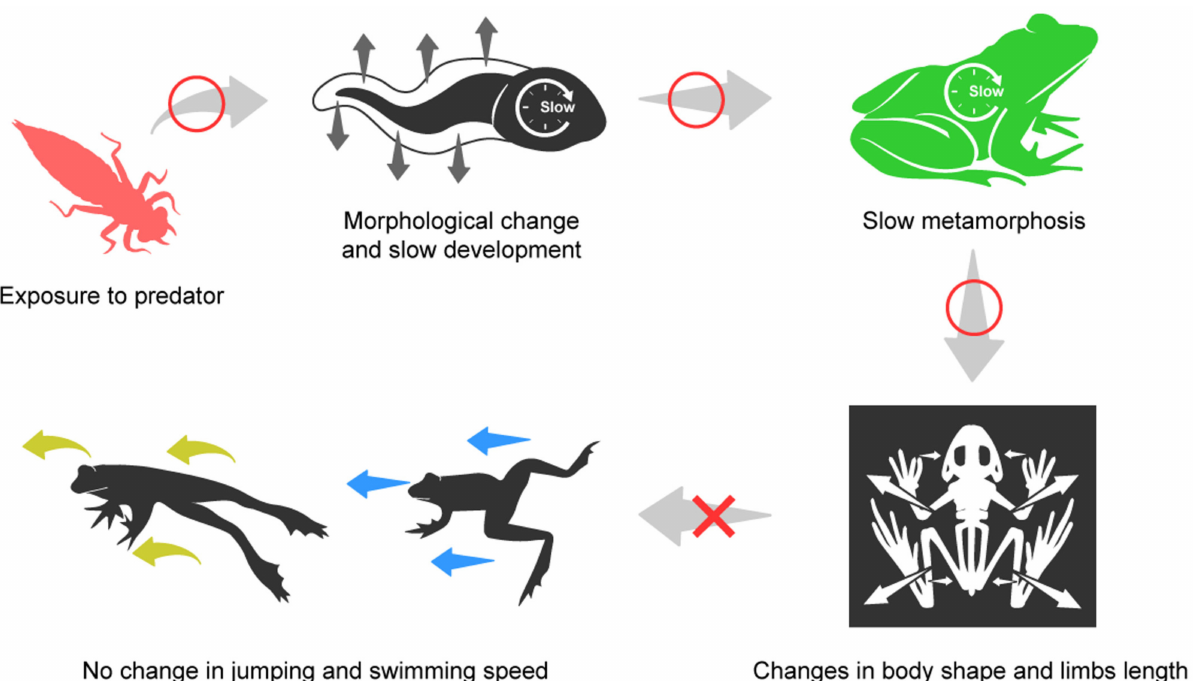
Figure 7. The response of tadpoles to the presence of predators and the effects of such a response following metamorphosis. The shape of the tail and the rate of metamorphosis in tadpoles, as well as—subsequently—the skeletal shape in juvenile frogs were all altered in the presence of a predator. However, there was no change found in respect to the jumping and swimming speeds of these subjects in the presence of